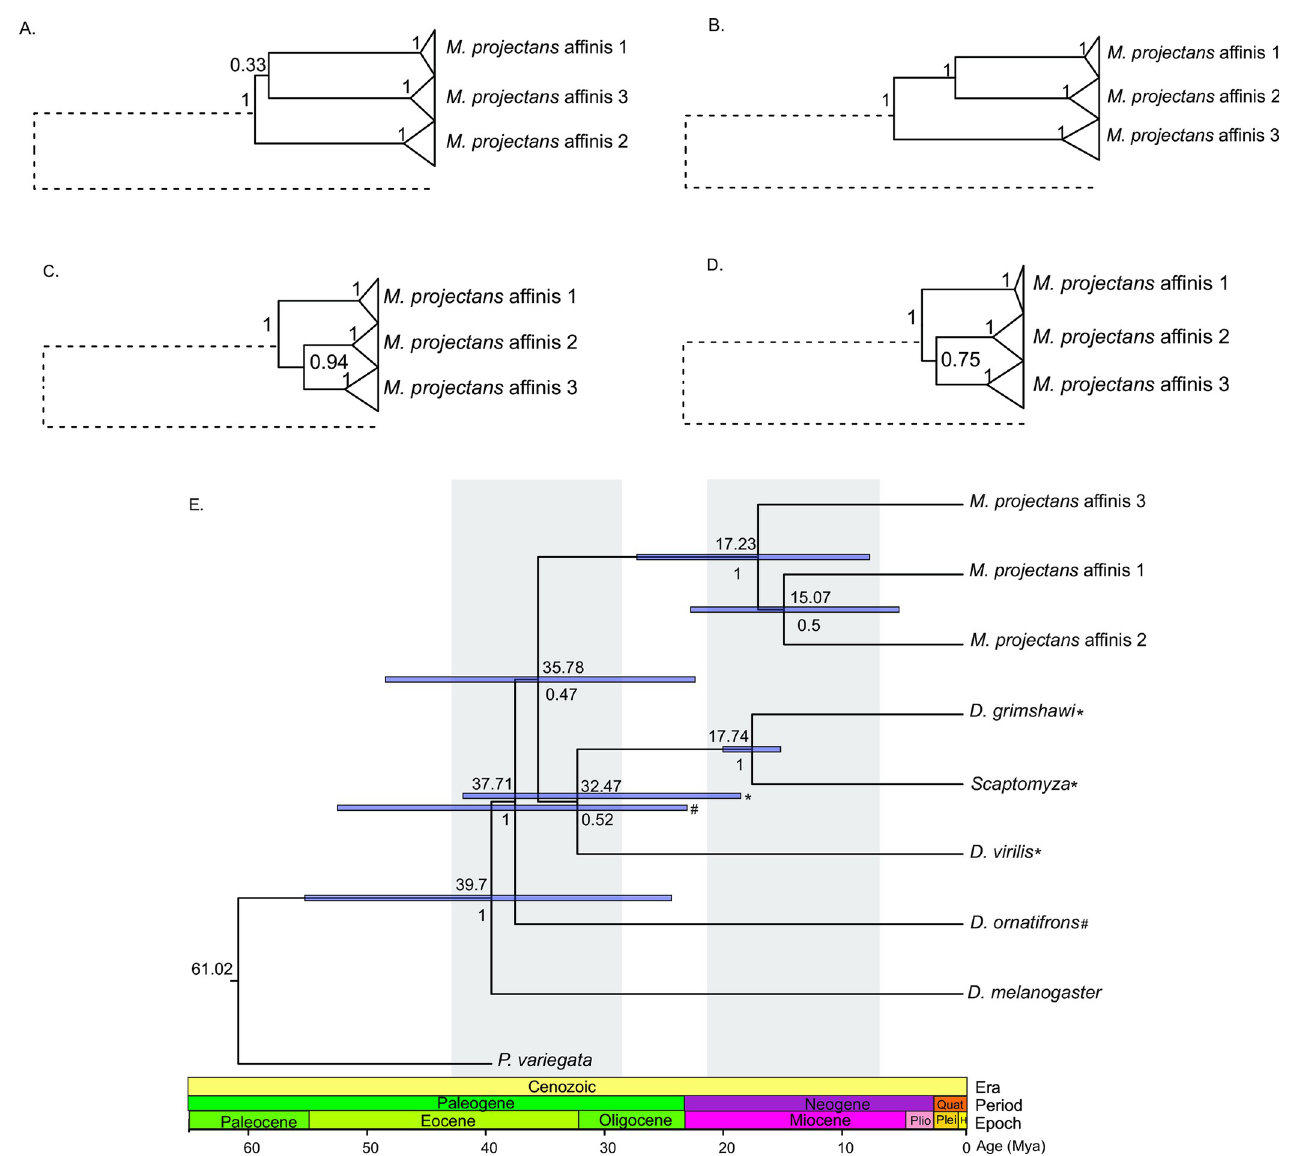
Fig 4. Phylogenetic trees recovered by Starbeast. (A) COI gene tree, (B) COII gene tree, (C) HB gene tree, (D) AMD gene tree, and (E) multi-locus species tree. Numbers above internal nodes in the gene trees and below the internal nodes in the species tree represent support values, as represented by the posterior probability (PP) of each clade. Numbers above internal nodes in the species tree represent mean divergence dates. Bars within internal nodes represent the confidence intervals